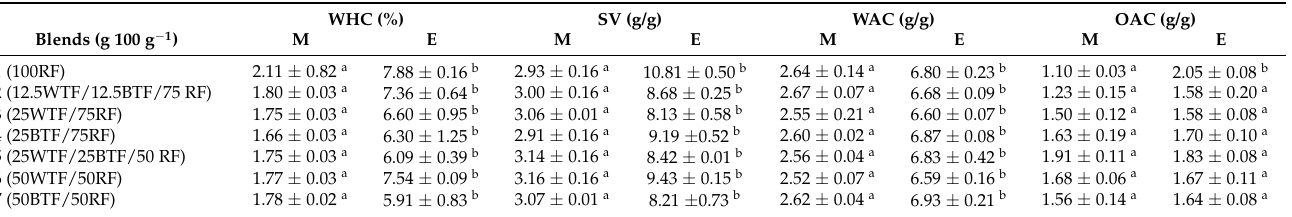
Table 5. Hydration properties of flours expressed as water holding capacity index (WHC), swelling volume (SV), water activity (WAC), and oil absorption capacity